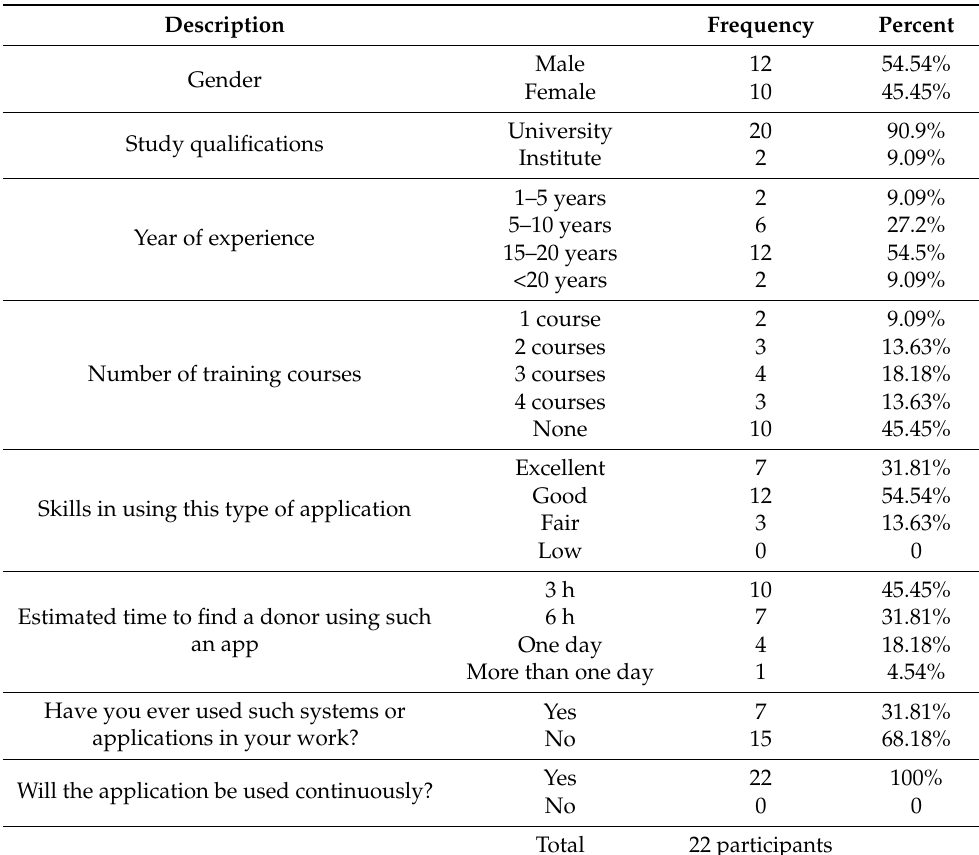
Table 5. Demographic details of the